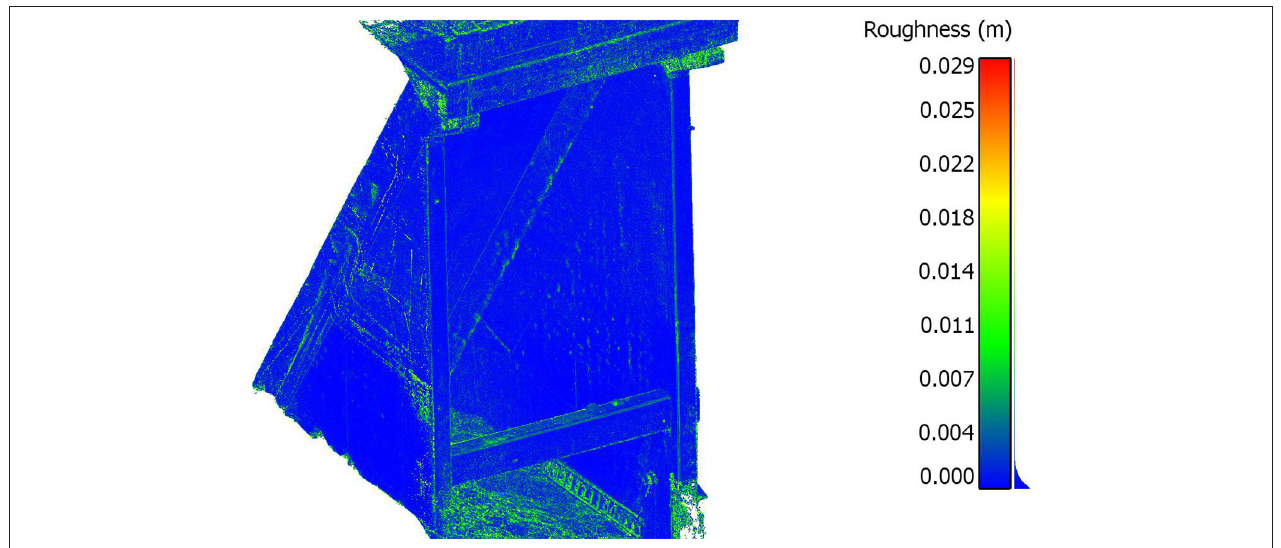
FIGURE 7 | Estimated noise level (lowest eigenvalue λ 0 ) for Bay#5; low to high noise level ranges from dark to light intensity.